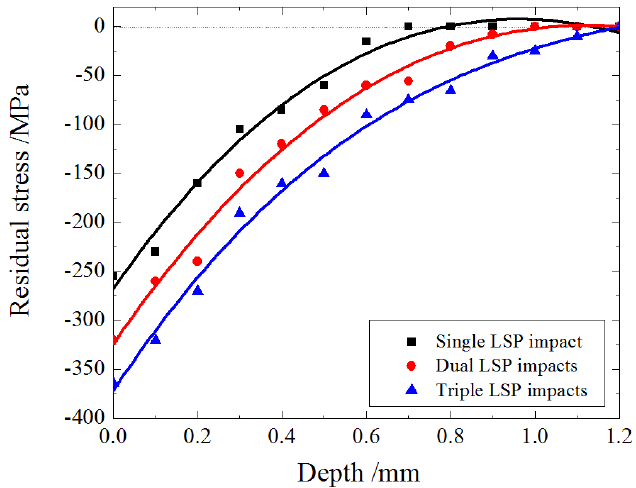
Figure 5. In-depth residual stress distributions of the spot center subjected to different LSP impacts.